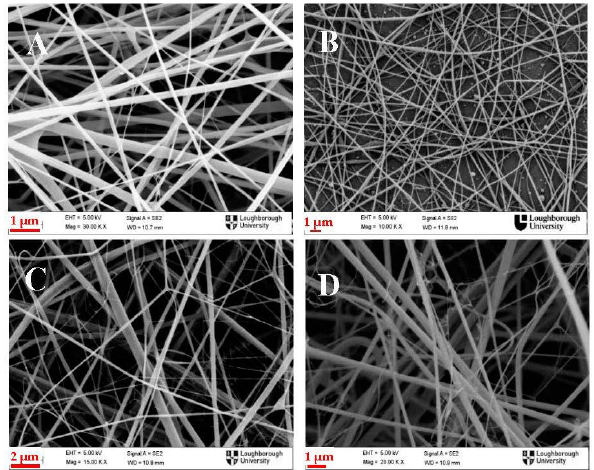
Figure 1. SEM images of: ( A ) Pure Chitosan; ( B ) Polyaniline/Chitosan (PANI/CS) 1:3; ( C ) PANI/CS 3:5; and ( D ) PANI/CS 1:1 electrospun membranes. Images are representative of three membranes prepared for each condition.